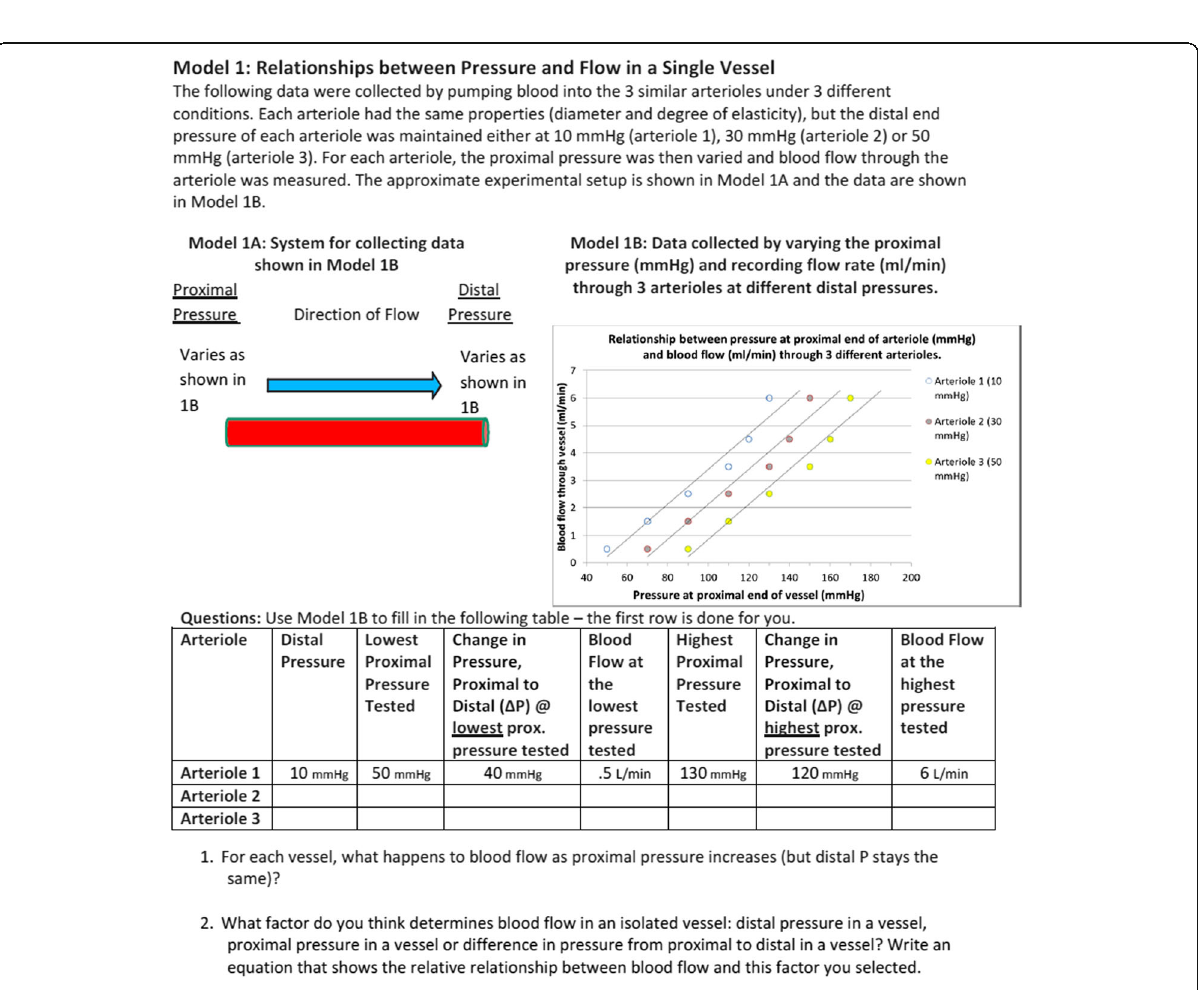
Fig. 2 The first part of the biology inquiry-based worksheet used in the think-aloud